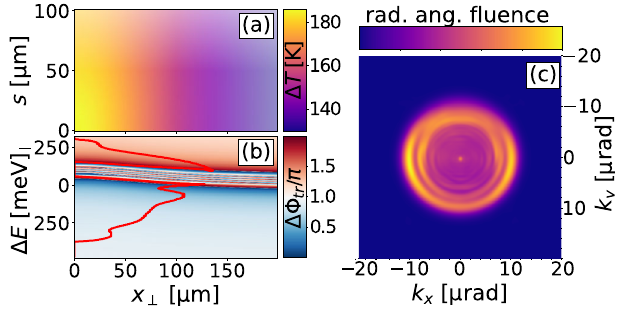
FIG. 8. Distribution of the downstream crystal temperature Δ T ¼ T − T ð a Þ at the arrival of the x-ray pulse at the c c; base 92nd round trip. This temperature distribution brings a spatially ¼ phase ð t Þð b Þ . varying, transmission induced phase shift ΔΦ 00 tr As a spatial gradient in the phase relates to a shift in the wavefront, the transmitted pulse, highlighted by the red line in (b) denoting the 99% contour, undergoes strong distortions. Latter is evident from the radiant angular fluence in the angular domain(c), which is exhibiting strong deviations from a Gaussian profile and an rms ≈ 20 μ rad far bigger than the undisturbed divergence of σ k x;y ≈ 1 . 1 μ σ k x;y